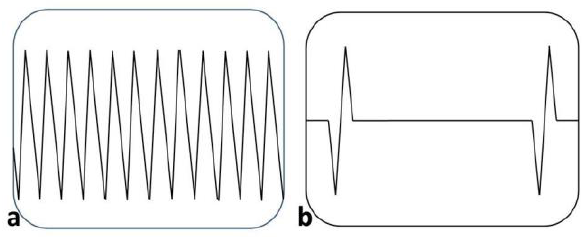
Figure 3a: (Left) showing the continuous waveform generated in ESU for pure “Cut” function and 3b: (Right) interrupted waveform for a “Coagulation” function.